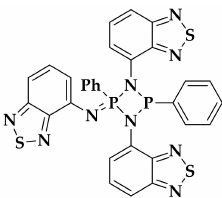
Figure 1. Skeletal formula of the by-product ( 4